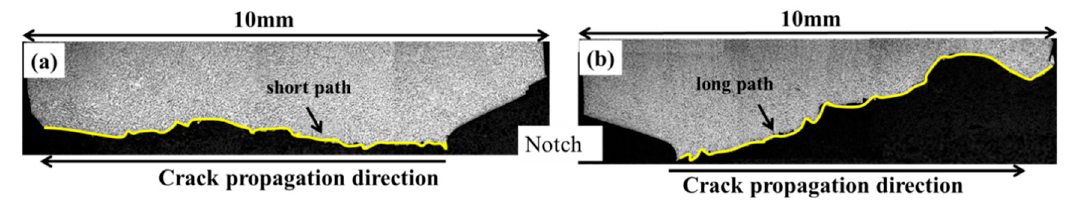
Figure 9. The representative crack propagation path in the impact specimens: ( a ) RD-TD specimen; ( b ) RD-ND specimen.